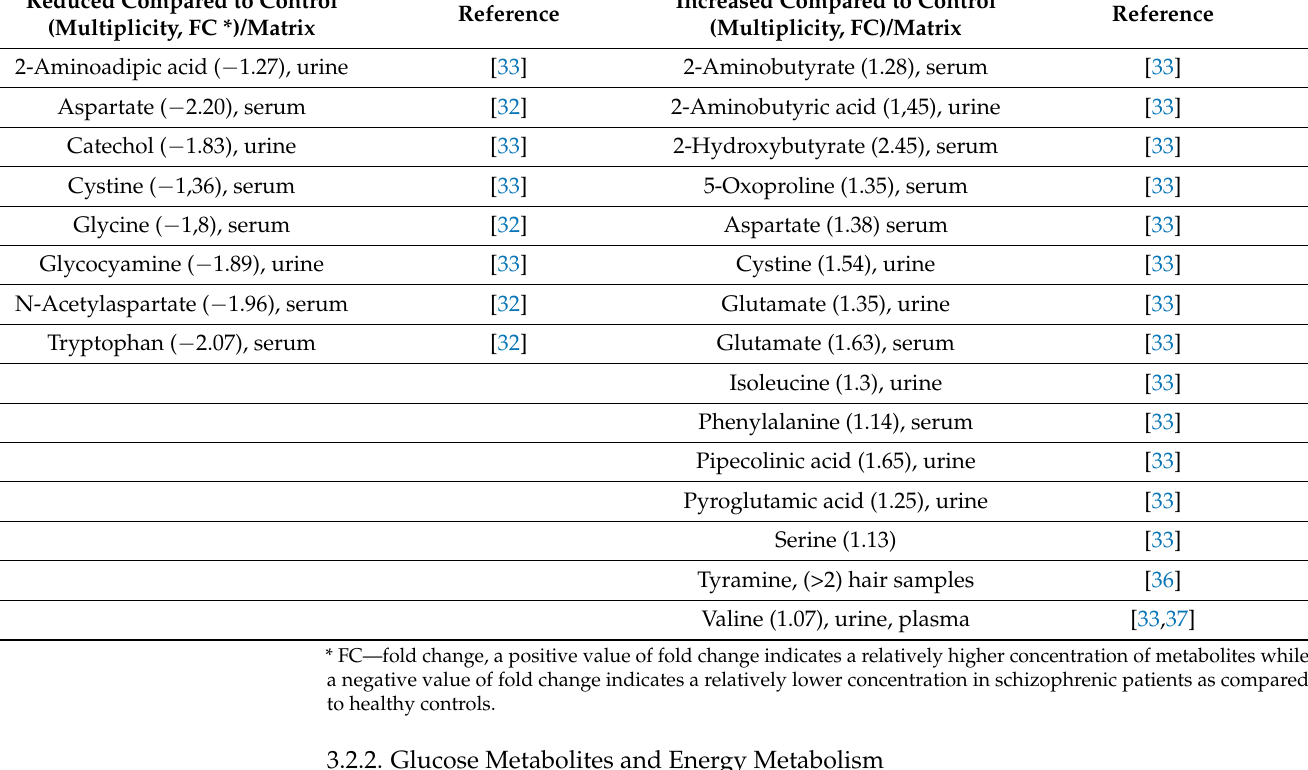
Table 2. Differentiating amino acids and amino acid metabolites between schizophrenic patients and healthy